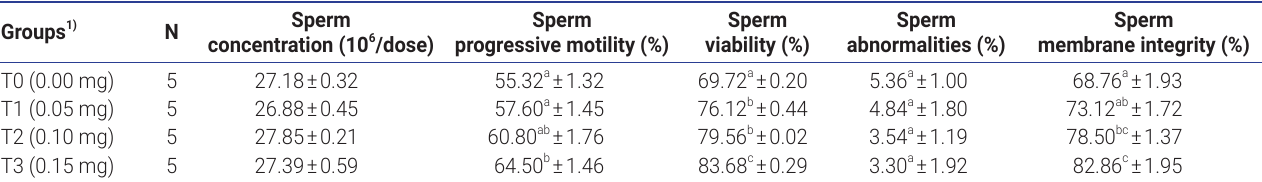
Sperm concentration (10 6 /dose)